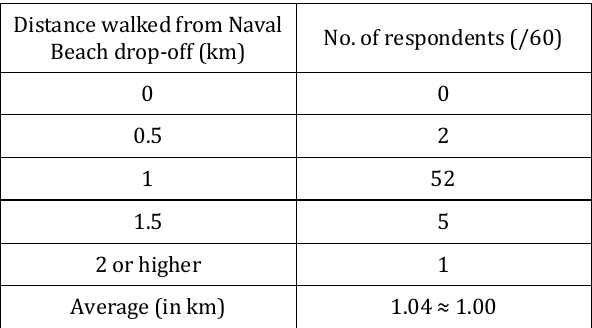
Table 1. Average distance walked by respondents (source: pilot